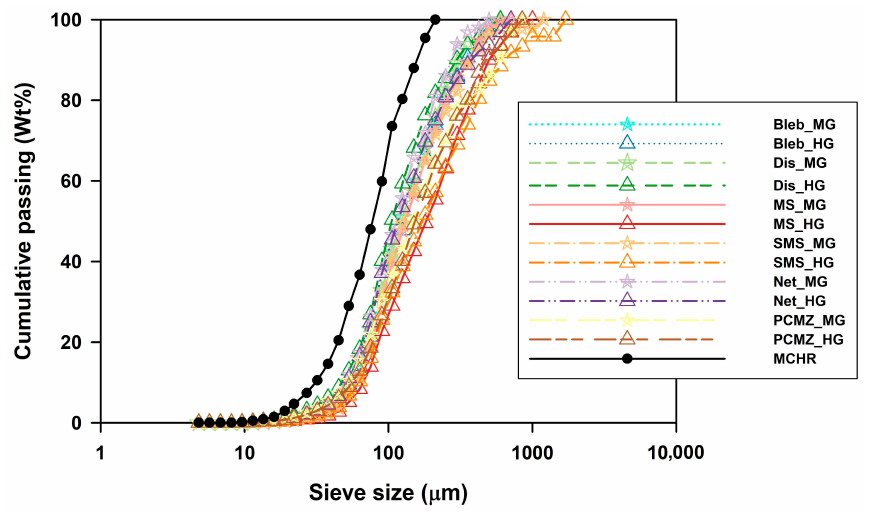
Figure 9. Pentlandite grain size distributions (equivalent circle diameter) for the samples of the various ore types collected from the MMZ and the PCMZ (crushed to − 2